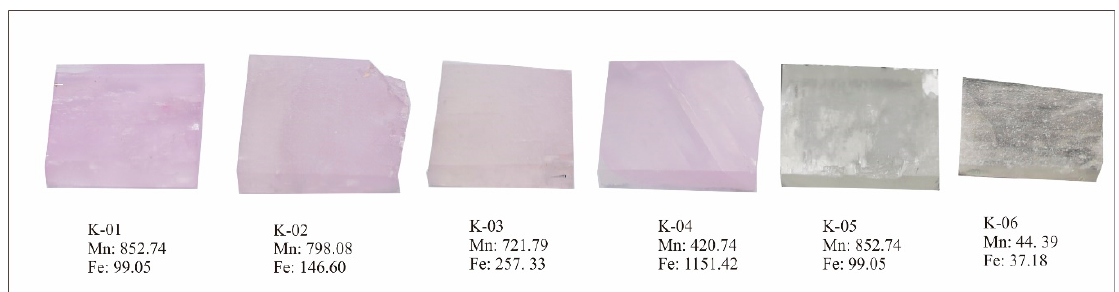
Figure 3. Six kunzite samples which were cut into wafers with dimensions 2 cm × 2 cm × 0.5 cm, (length, width, and thickness, respectively). These samples were used for X-ray absorption near-edge structure (XANES) and UV − VIS spectra. These samples were selected according to the Mn and Fe concentration and each sample’s value is written below the sample in ppm (average).